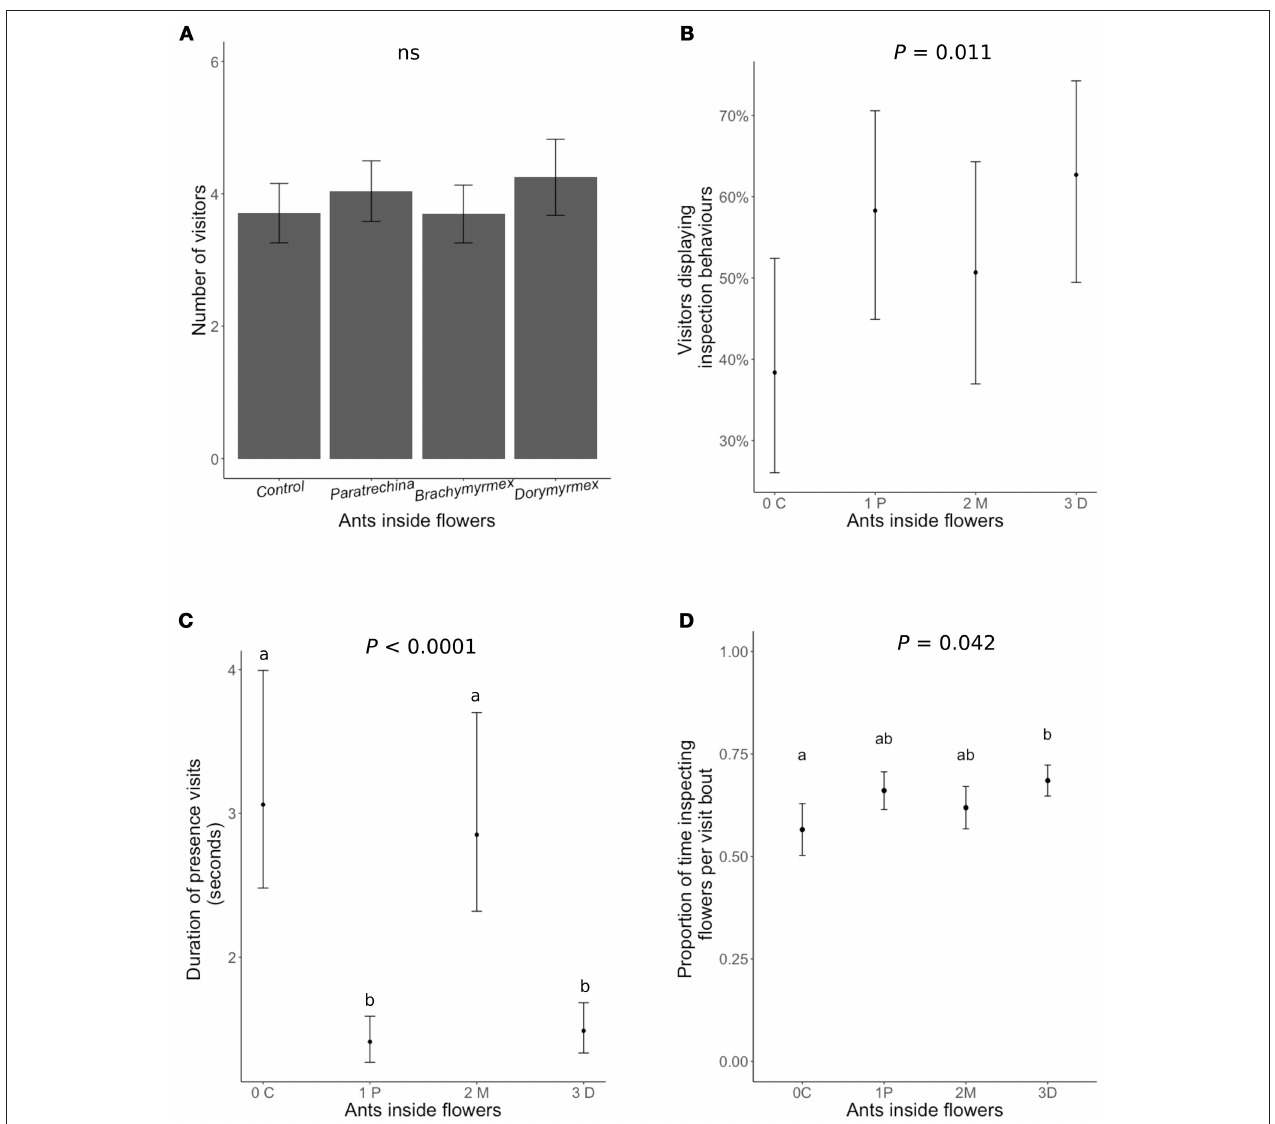
FIGURE 3 | The effect of dead ants inside the flowers of Turnera velutina on different aspects of the behavior of visiting honeybees: (A) visitation frequency, (B) the percentage of visitors of displaying inspection behaviors, (C) the duration of contact visits (time spent inside the flower), and (D) proportion of time spent inspecting the flowers per visit bout (hovering over the floral head space). Ant species are arranged in order of increasing aggressivity and names are abbreviated: C, control with no ants; 1P, Paratrechina longicornis ; 2M, Brachymyrmex sp.; 3D, Dorymyrmex bicolor ants. ( n = 40 plants; n = 160